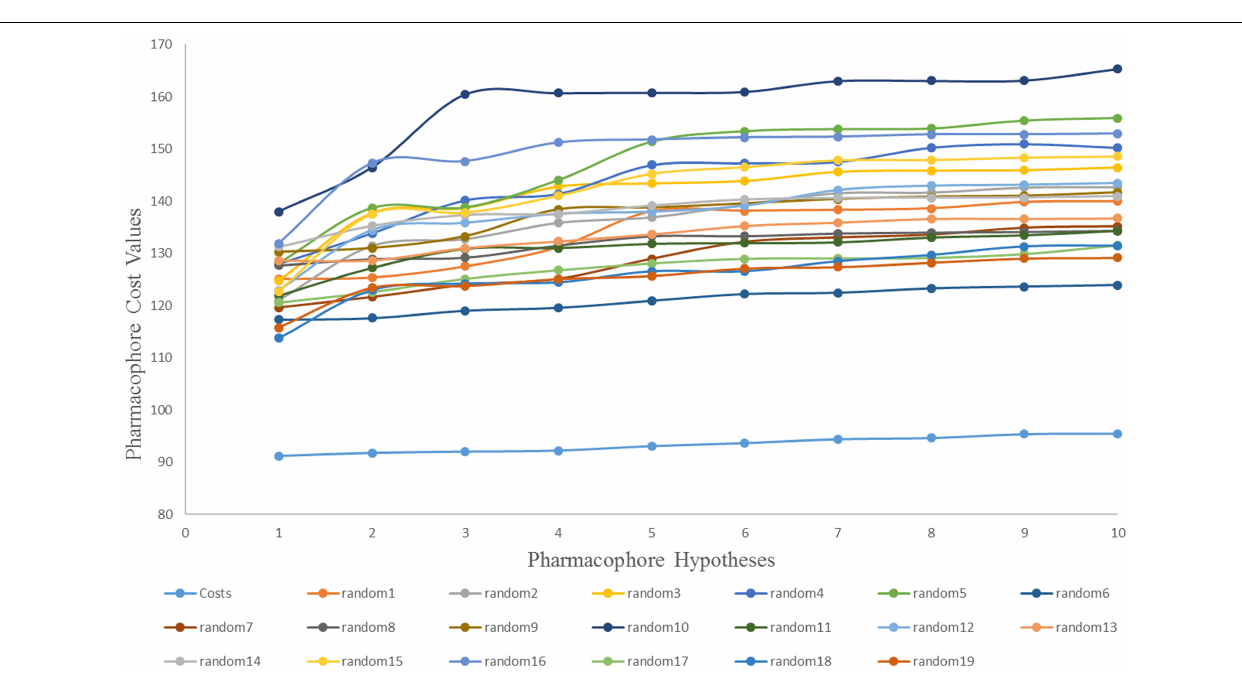
FIGURE 4 | The difference in cost between the initial hypothesis and 19 random hypotheses. The 95% confidence level was selected to validate the Fischer randomization test results